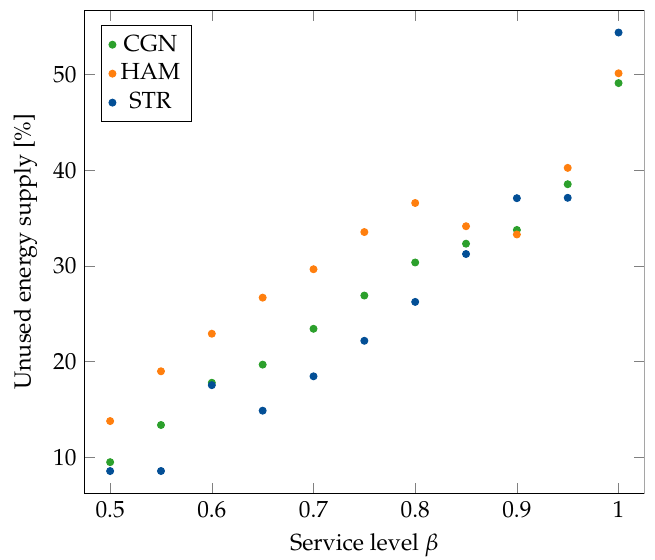
Figure 10. Unused energy supply for different service levels for a bus capacity of 100kWh.